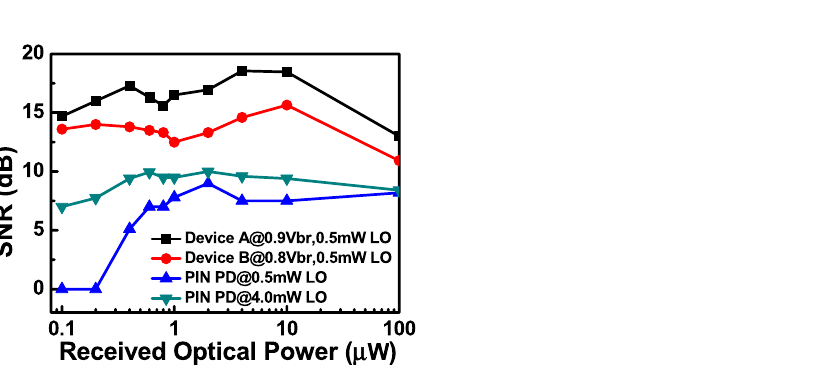
Figure 14. Measured SNR vs. received optical power of different receivers under optimal